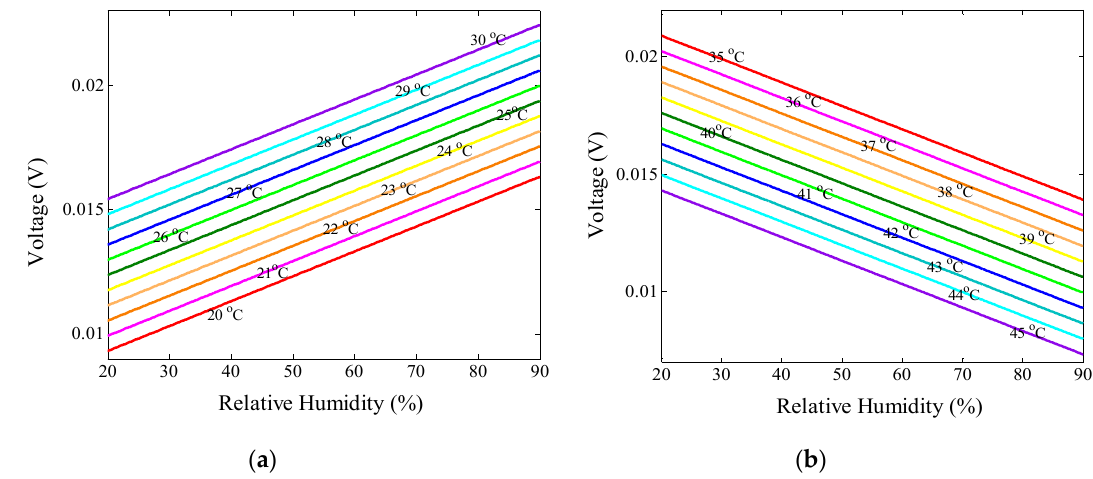
Figure 11. The detailed results of the measured voltages vs. RHs: ( a ) 20 °C to 30 °C, with λ B ; ( b ) 35 °C to 45 °C, with λ A .